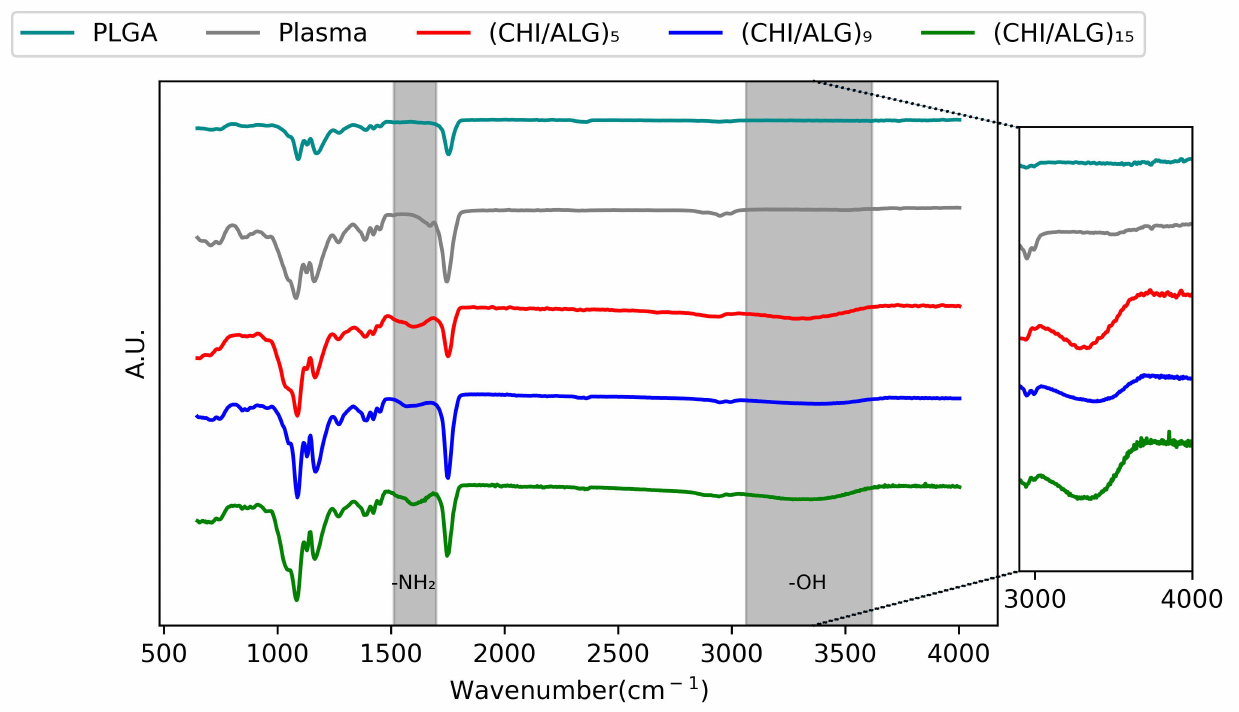
Figure 3. AT-FTIR of PLGA, plasma-coated, (CHI/ALG) 5 , (CHI/ALG) 9 , and (CHI/ALG) 15 electrospun nanofibers. The inset highlights the differences between the peaks in the 3000–4000 cm − 1 region corresponding to the alcohol function present on both alginate and chitosan polymeric backbones. The region from 1550 to 1650 cm − 1 describes the apparition of the amino function present in the chitosan polymeric